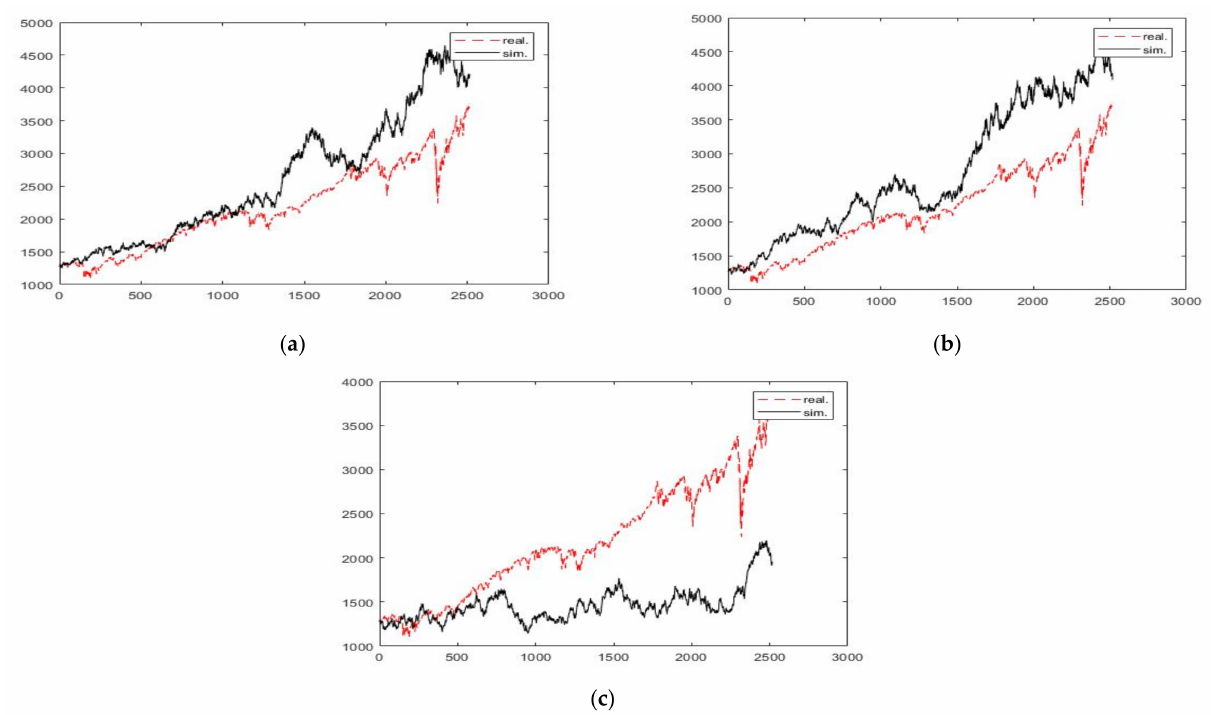
Figure 4. Simulation results using GFBM (10-year period): ( a ) Hurst PE, ( b ) Hurst RS, ( c ) Hurst 0.5.